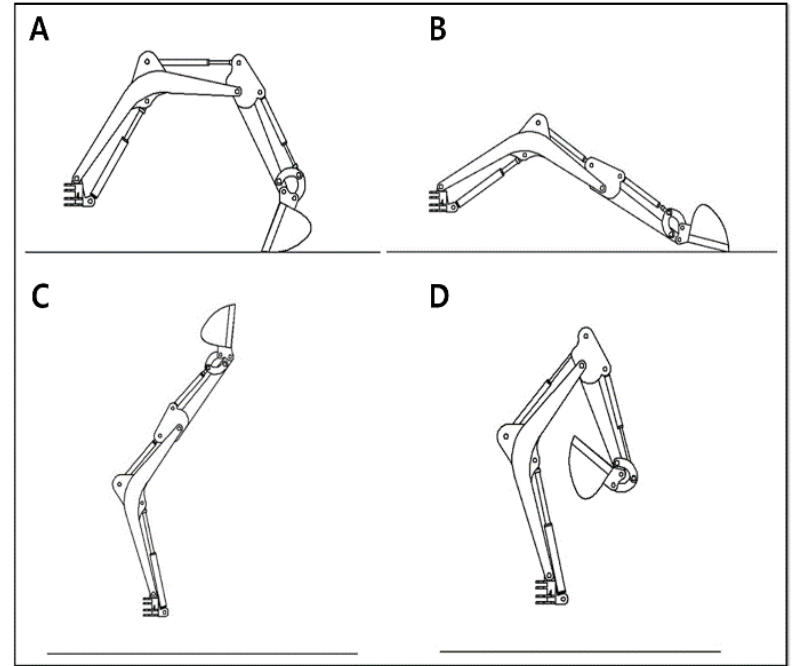
Figure 12. The four main poses of the excavator to synchronize the initial and final points by inserting the offset value. ( A ) the middle point in aspect of the horizontal side view; ( B ) the pose when all links of the excavator are stretched as much as possible; ( C ) the pose when the excavator making a maximum height; ( D ) when all cylinders have a minimum length.